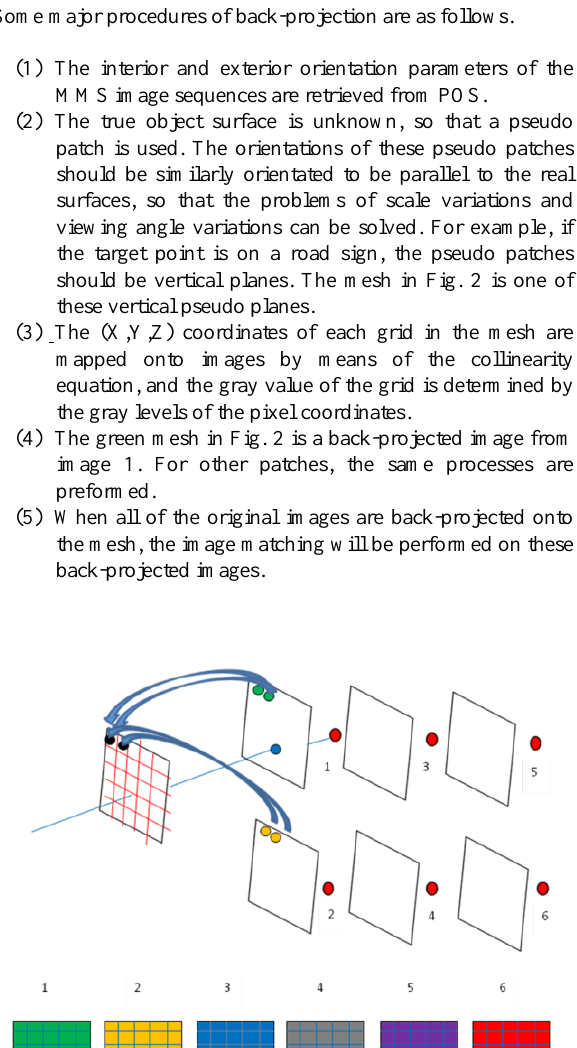
Figure 4. An example of road surface image back projection: (a) the original images and (b) back-projected images of horizontal pseudo patch, in which the viewing angle differences between Figure 2. The implementation of back-projection from MMS images are image sequences.